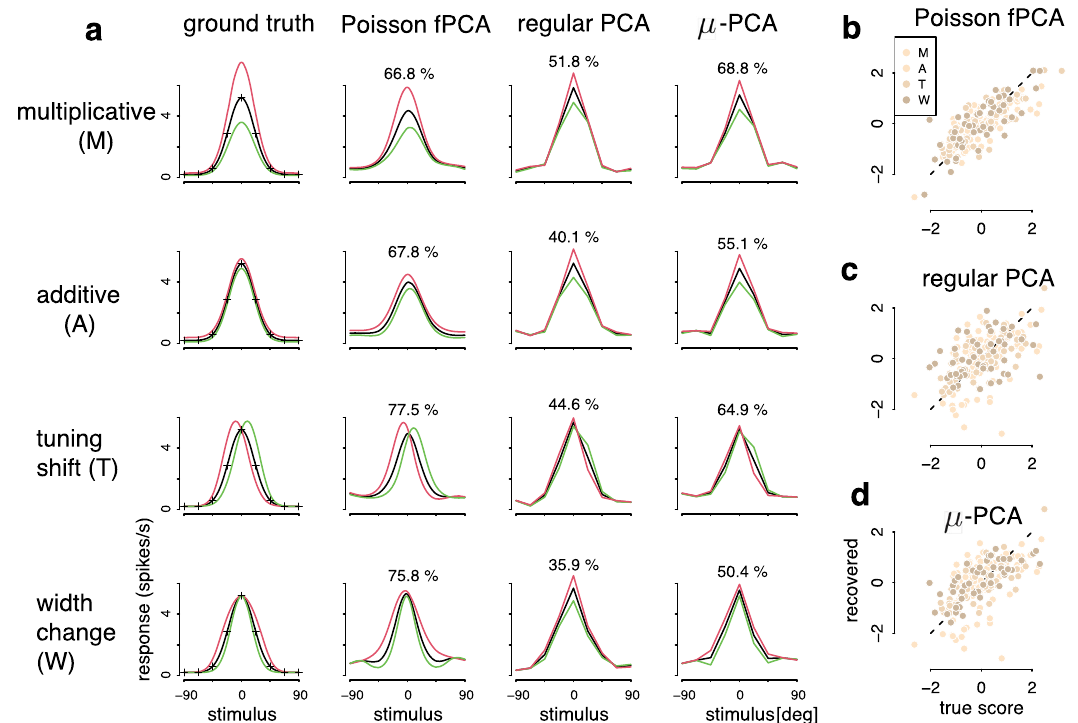
Fig.2|Modelvalidationwithbell-shapetuningcurves.a Inferred fl uctuationsof four types of tuning fl uctuations. Black curve: the tuning curve with zero fl uctua- tion. This corresponds to the mean component exponentiated. Red/green curves: thecorrespondingtuningcurveswhensettingthescoretobe±1standarddeviation of the scores. Crosses in the fi rst column: the set of discrete stimuli used in the simulation. From left to right: ground truth, Pf-PCA, regular PCA, and a reduced version of Pf-PCA termed as μ -PCA. In each case, we simulated neural responses from the corresponding ground truth model, and then inferred the form of the fl uctuationanditsmagnitudeforeachmoment.Thepercentagesontheplotsshow